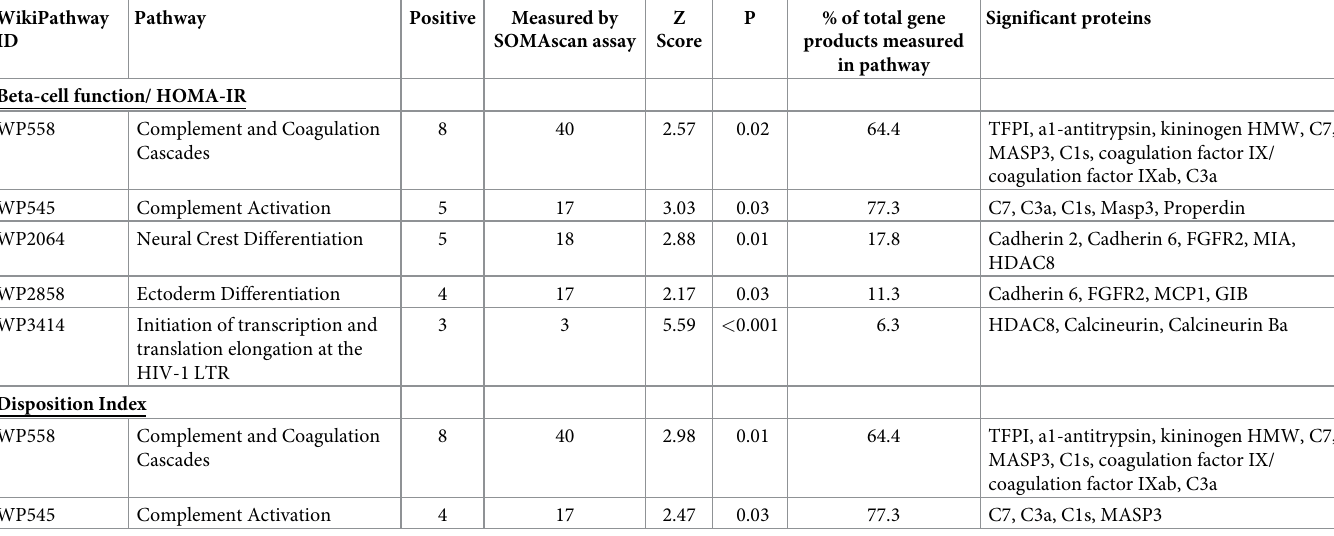
Table 4. Pathways significantly related to beta-cell function measures.